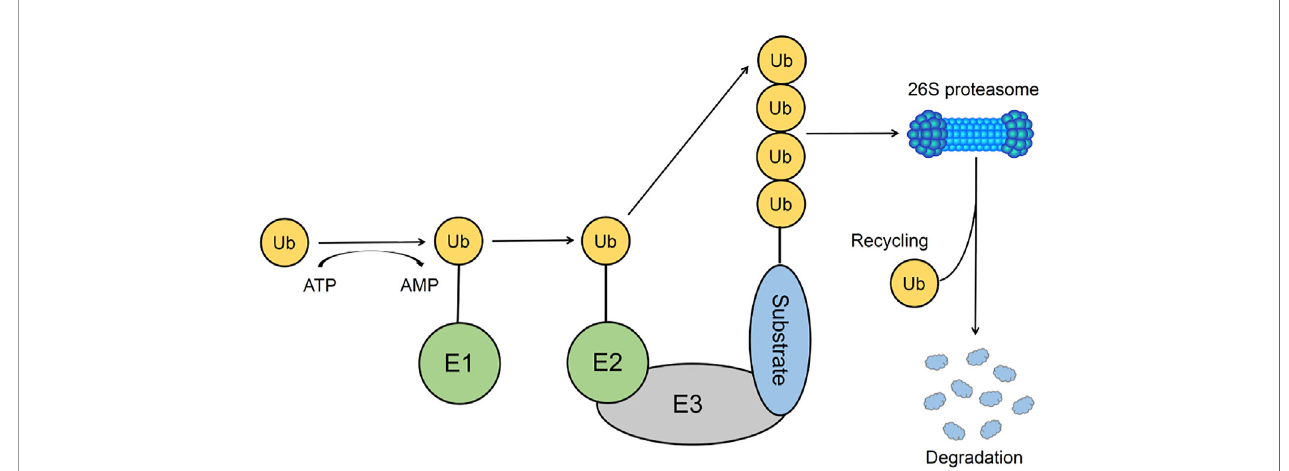
FIGURE 1 | The Ubiquitin-Proteasome System. The conjugation reaction of ubiquitin is catalyzed by the E1 ubiquitin-activating enzyme, E2 ubiquitin-conjugating enzymes, and E3 ubiquitin ligases. E3 ubiquitin ligase could recognize substrates and transfer ubiquitin from E2 ubiquitin-conjugating enzymes to substrates, resulting in the proteasome degradation of the polyubiquitinated